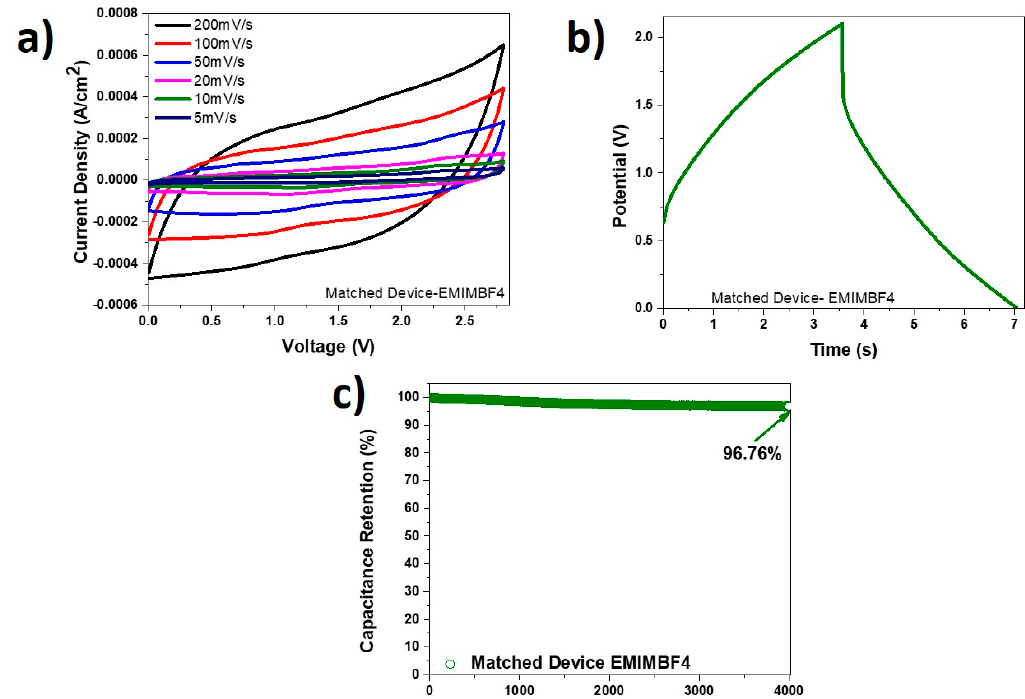
Figure 9. ( a ) CV curves at different scan rates for PVDF-EMIMBF4 device; ( b ) charge-discharge curve at current density of 0.5 mA/cm 2 for the PVDF-EMIMBF4 device; ( c ) capacitance retention of PVDF-EMIMBF4 device at current density of 1 mA/cm 2 tested over 4000 cycles.